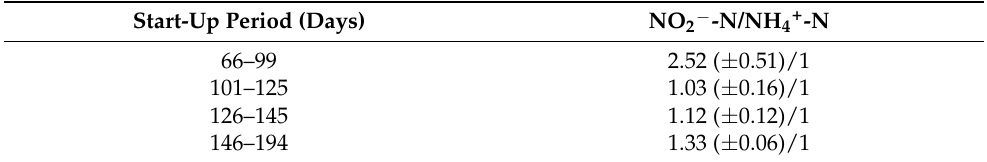
Table 1. The conversion ratio based on the mass balance NO 2 − -N/NH 4+ -N within the start-up